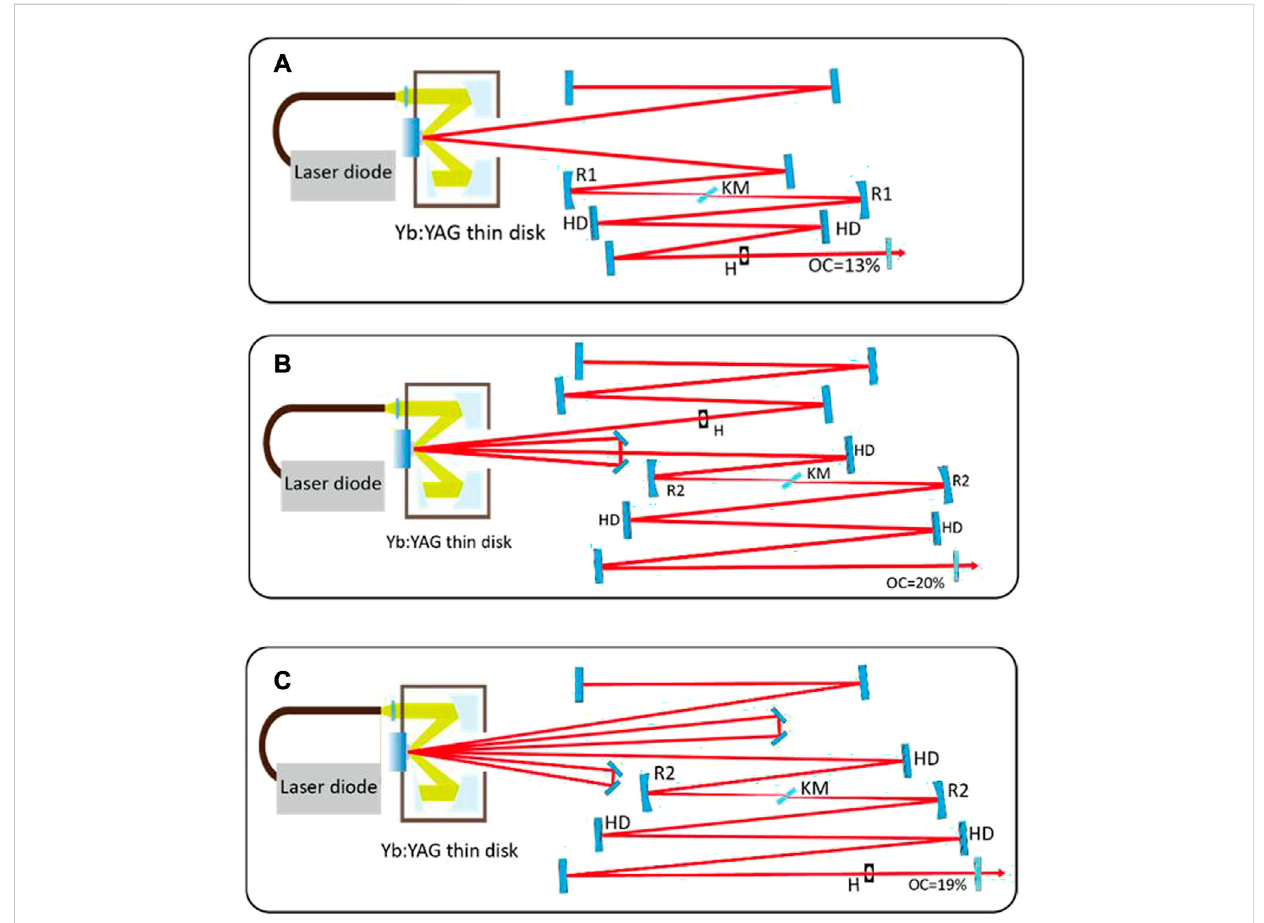
FIGURE 2 Schematics of the KLM thin-disk Yb:YAG oscillator realized with passes of (A) four, (B) eight, and (C) twelve. HR: All fl at mirrors are highly re fl ective; HD: High-dispersion mirrors; OC: Output coupler; KM: Kerr medium; H: Hard aperture; R1 and R2: Concave mirrors with radius of curvature (ROC) of − 250 mm and − 500 mm, respectively.